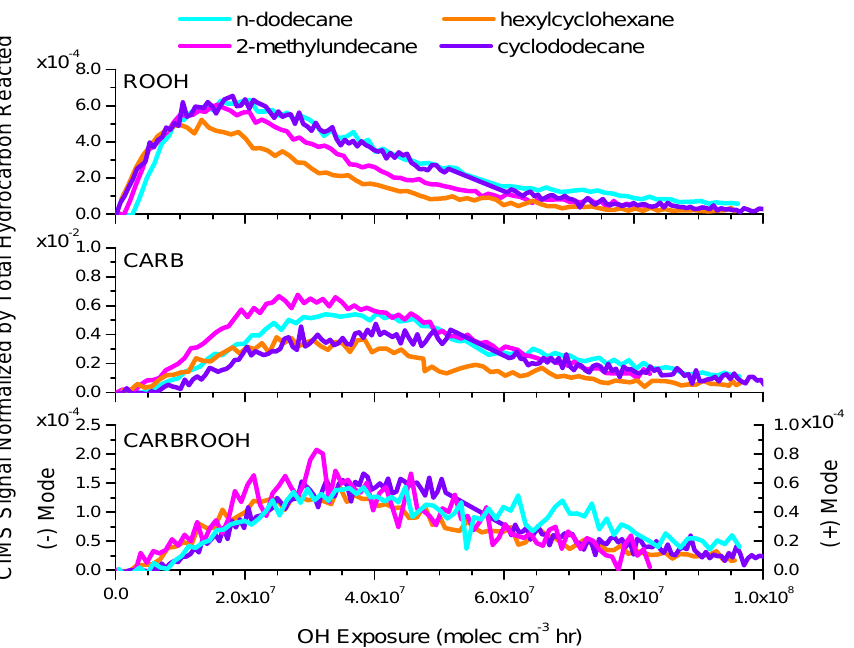
Fig. 3. Gas-phase trends of major species formed in the first three generations of photooxidation. Top panel: first-generation hydroperoxide (ROOH). Middle panel: second-generation carbonyl (CARB). Bottom panel: third-generation carbonyl hydroperoxide (CARBROOH). Note that the CARBROOH was monitored in positive mode for n -dodecane and 2-methylundecane (the right side axis) and in negative mode for hexylcyclohexane and cyclododecane (the left side axis).